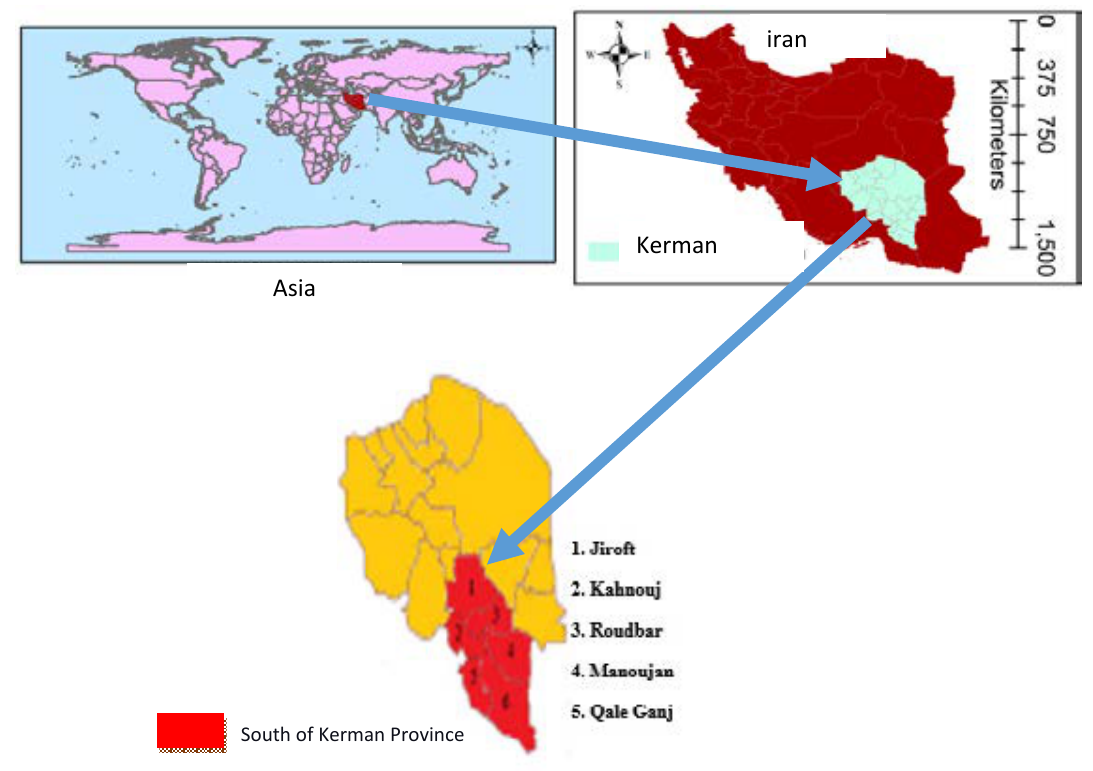
Fig. 2. Location of the study area